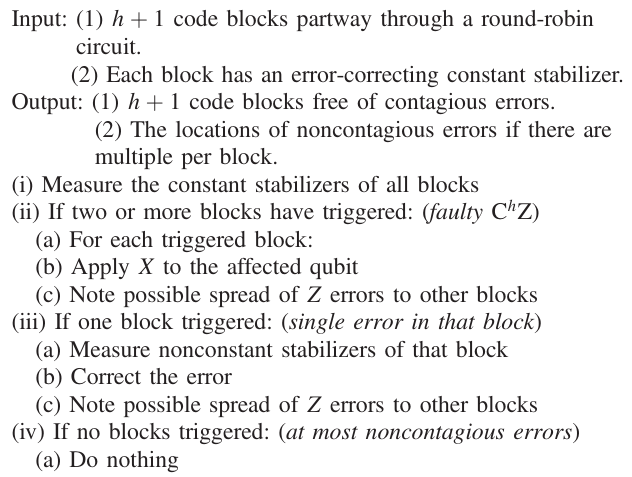
TABLE I. PARSEC. A procedure for doing intermediate error correction in the nonstabilizer codes encountered partway through the round-robin construction of logical CCZ and, in Sec. V, the constructions of Theorem V.1. An “ error-correcting constant stabilizer ” is one that can distinguish between all contagious errors modulo noncontagious errors, defined more formally in Sec.